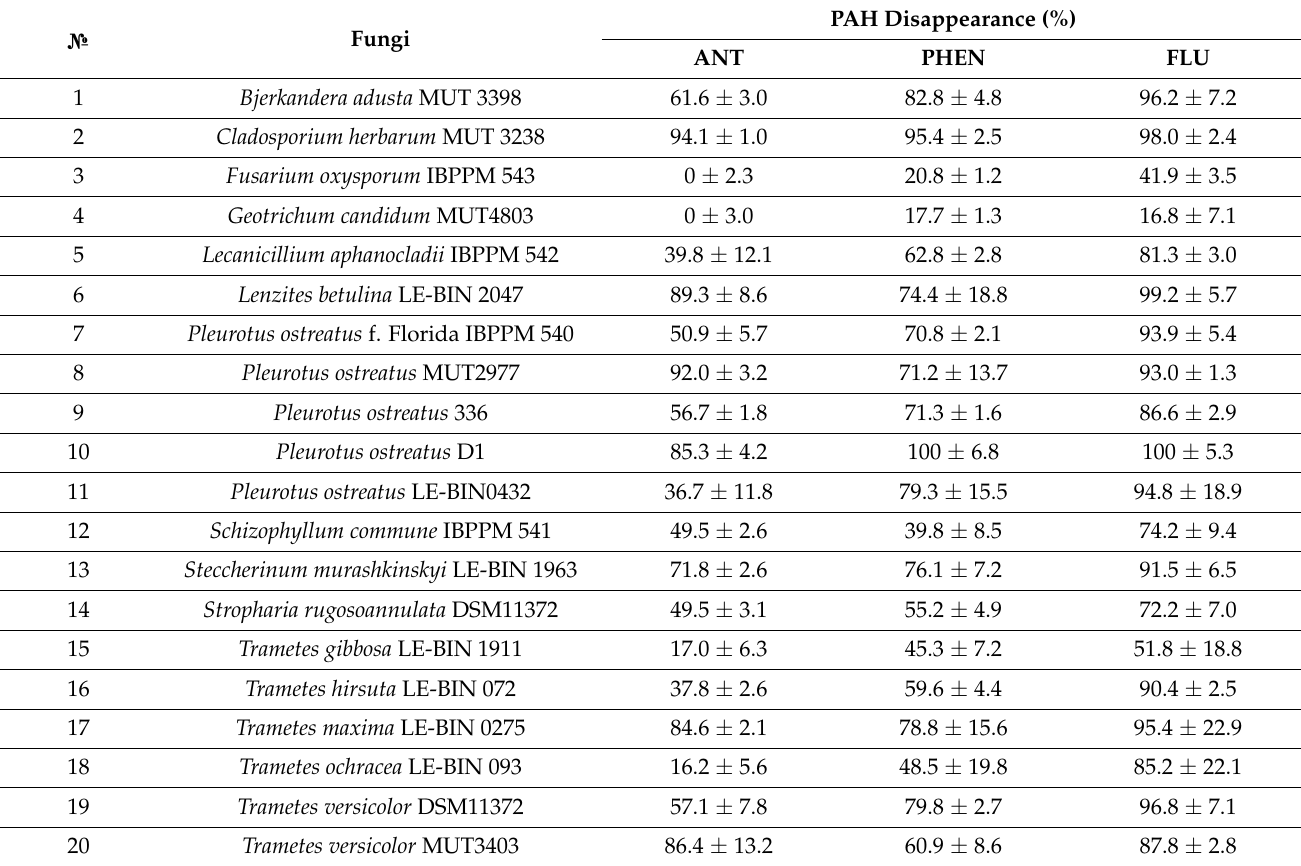
Table 1. PAHs disappearance (%) by the selected